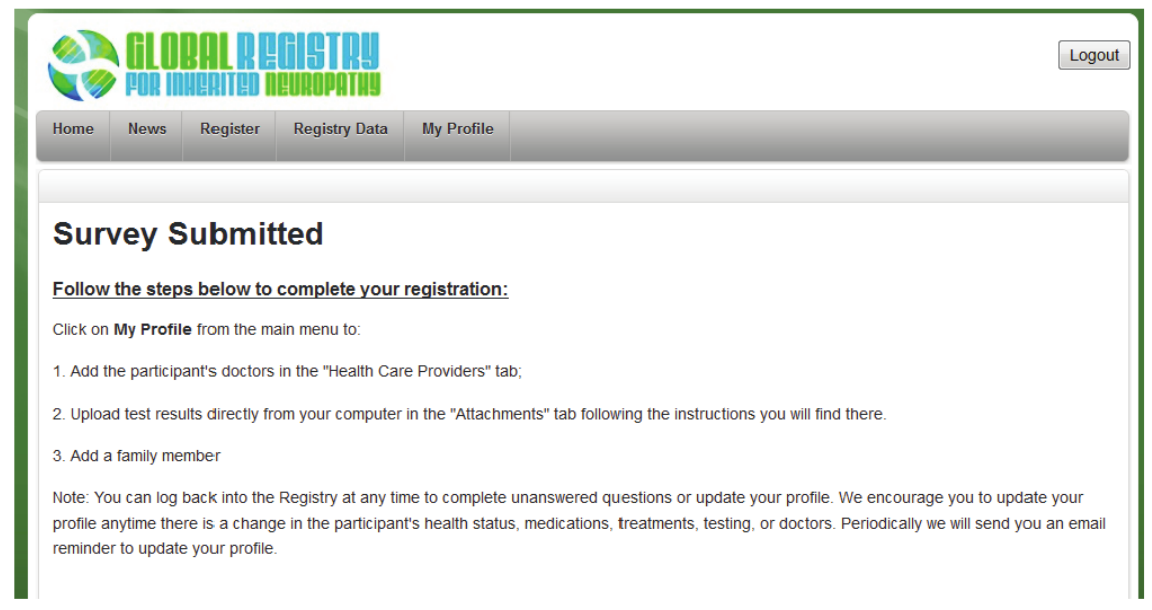
Supplemental Figure 11. Survey submission